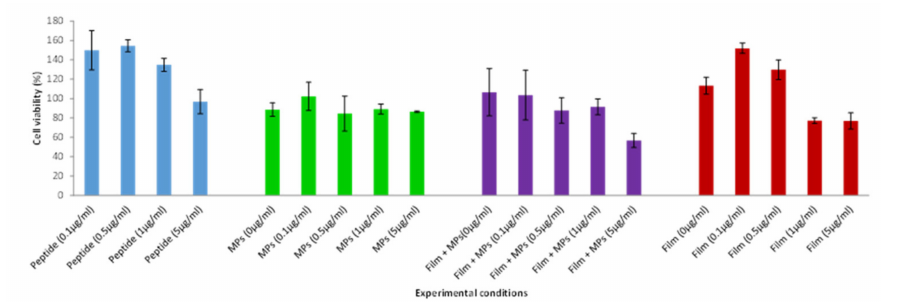
Figure 3. Cell viability (%, mean ± SD) when in contact with relaxing peptide, chitosan microparticles, guar-gum films, and chitosan microparticles loaded into guar-gum films with and without peptide, determined by the MTT assay after 24 h of contact ( n = 5).